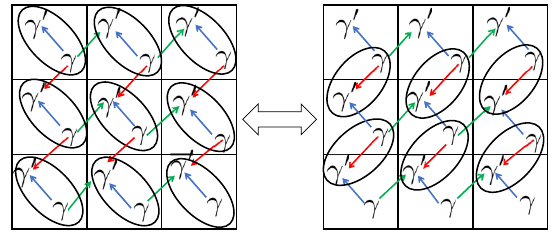
FIG. 6. The r = 1.5 construction is the same as the com- pact fermion-to-qubit mapping [9] after the re-pairing of Majo- rana fermions above. Each circle represents a complex fermion formed by the two Majorana fermions. The underlying arrows specify the order to form a fermion. The arrows form a Kaste- leyn orientation, ensuring that the fermion parity after re-pairing is well defined